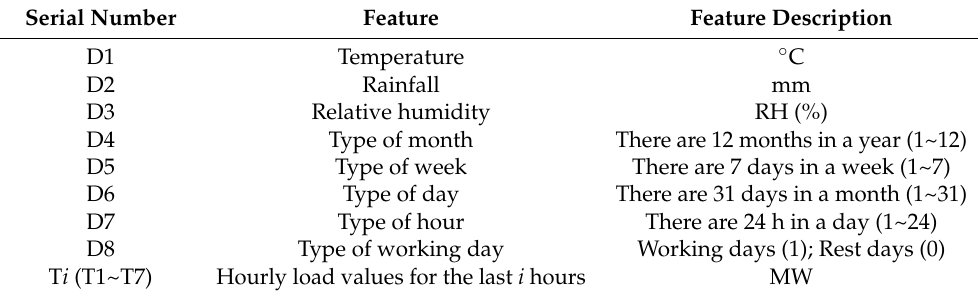
Table 3. Initial feature information table.